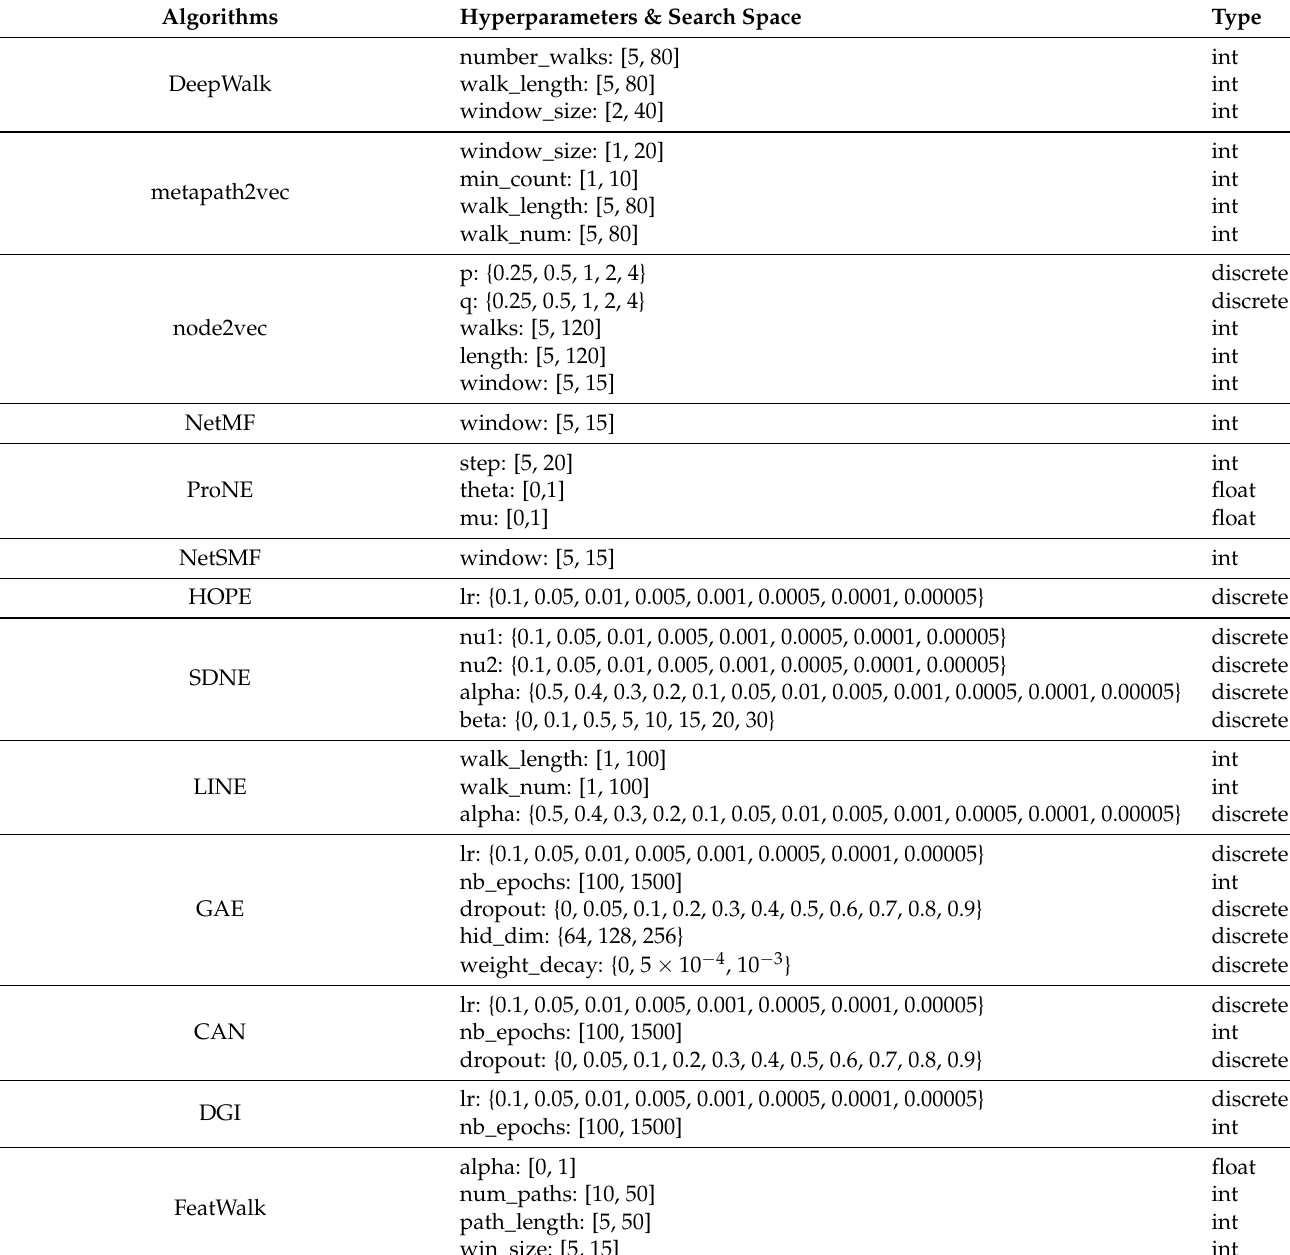
Table 1. Hyperparameter search space of unsupervised NRL